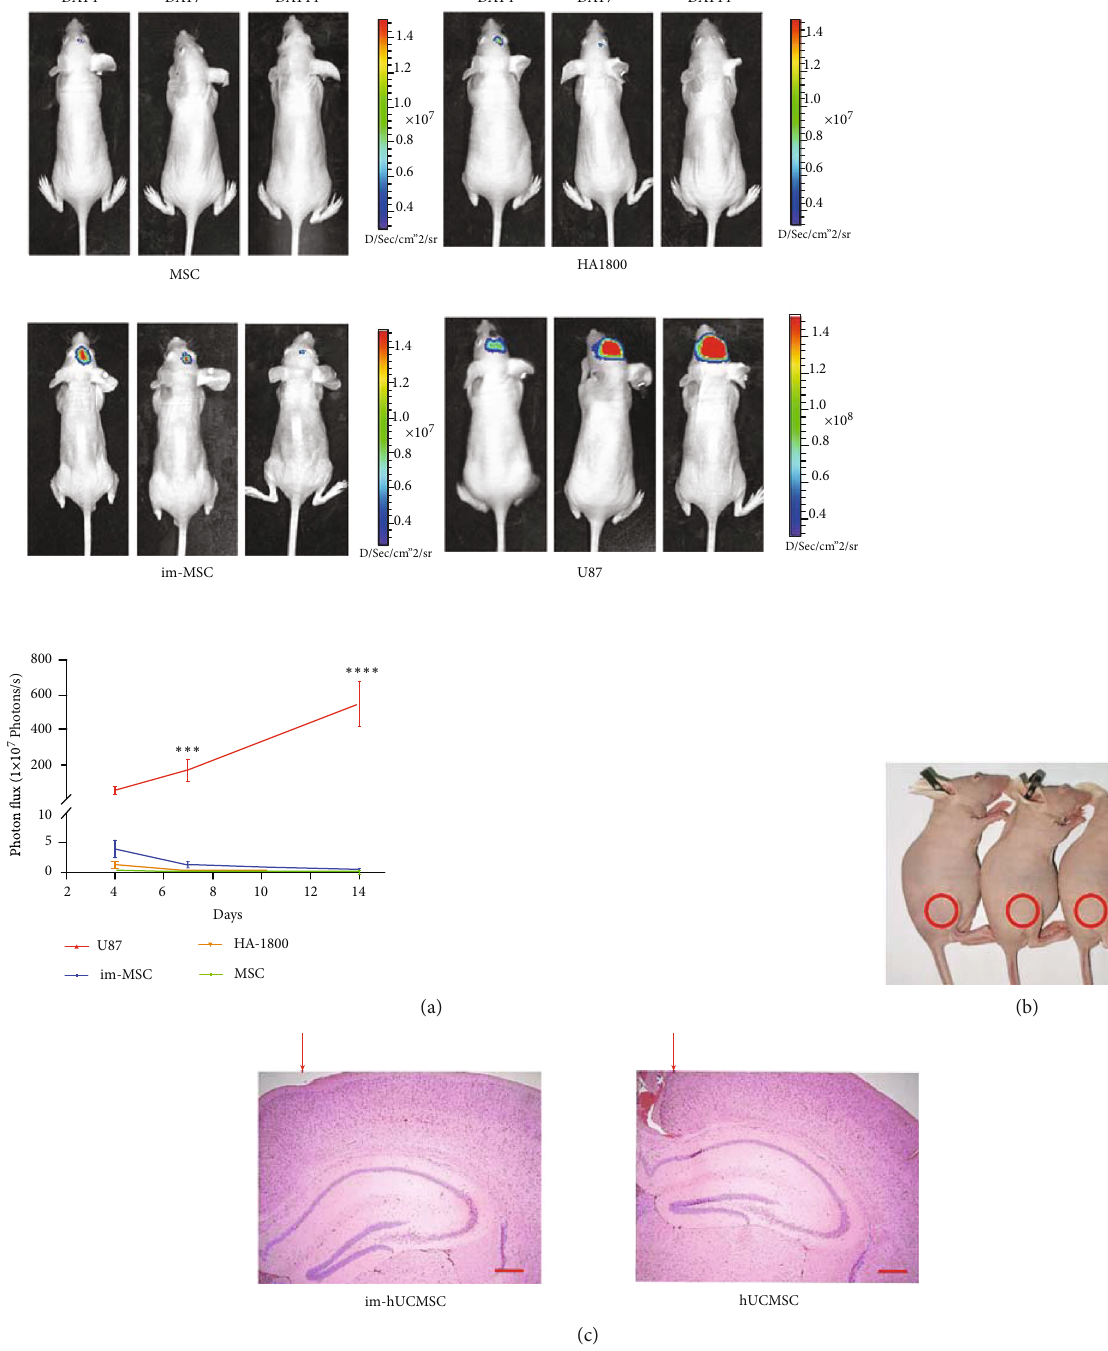
Figure 5: Safety of immortalized mesenchymal stem cells in vivo. (a) IVIS luminescent imaging of BALB/c nude mice with intracranial injection of immortalized umbilical cord mesenchymal stem cells (1 × 10 6 ). Line graph showing cell growth in the brain, U87 cells were used as a positive reference, and normal glial cells (HA1800) were used as a negative reference. (b) Im-hUCMSC were injected subcutaneously into the proximal right lower extremity of nude mice to evaluate tumorigenic; the picture was taken on the 14th day after injection. (c) HE staining shows that there was no abnormal tissue growth inside the brain where mesenchymal stem cells were injected. Red arrow indicates the direction of needle entry. Magni fi cation, × 50. Scale bar, 500 μ m. ∗∗∗ P < 0 : 001 , ∗∗∗ ∗ P < 0 : 0001 . IVIS: in vivo imaging system; HE: